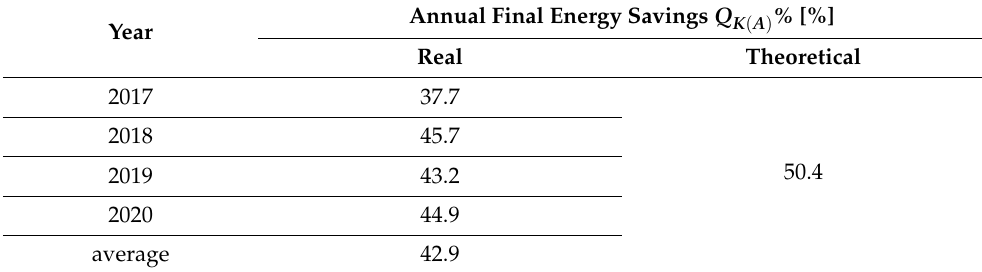
Table 11. Annual final energy savings in the tested building A in 2017–2020.